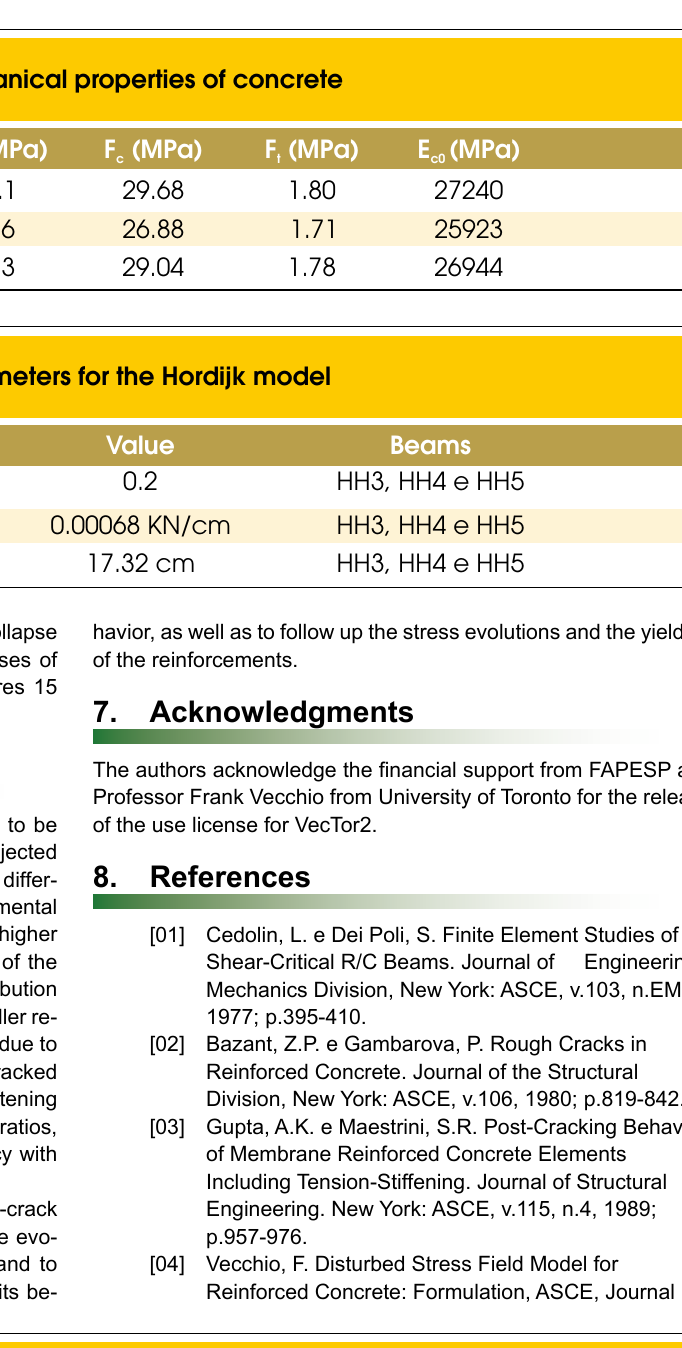
Figure 12 – Finite element mesh –